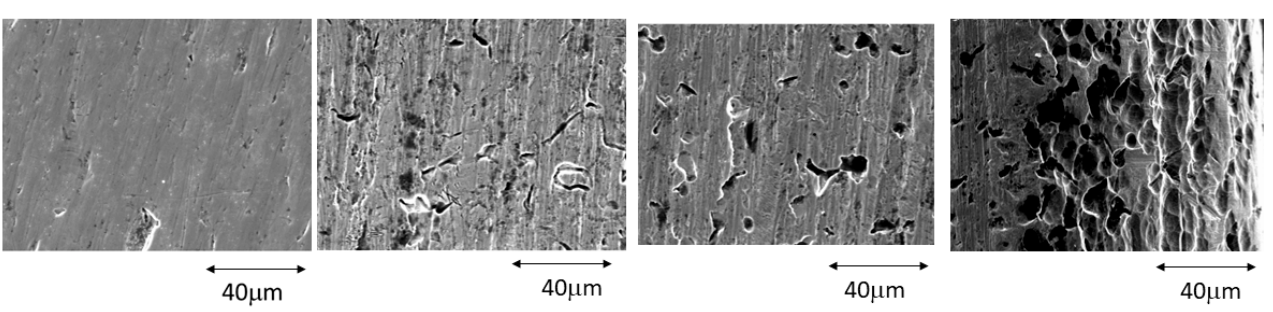
Figure 3. Ti-Mo surfaces after 1, 4, 7, and 14 days immersed in a 380 ppm fluoride solution.